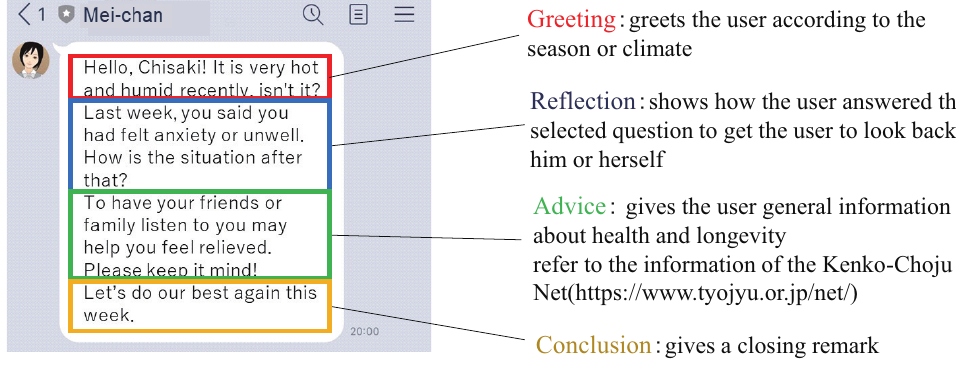
Figure 4. Example of the weekly feedback message with the structured four